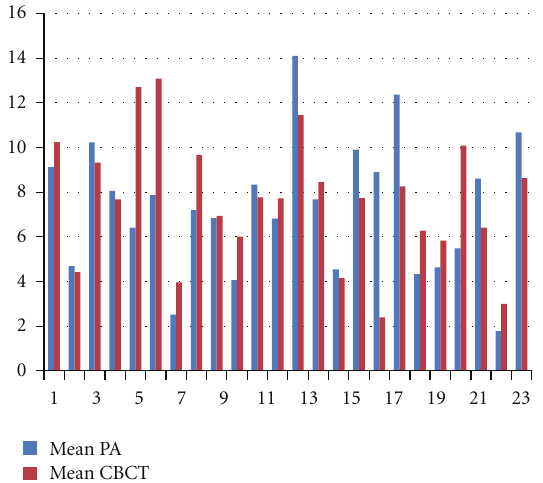
Figure 3: Mean of all lesion size measurements of 24 teeth by observers (6) comparing PA and CBCT. x -axis: number ( n ) of images, y -axis = lesion measurement